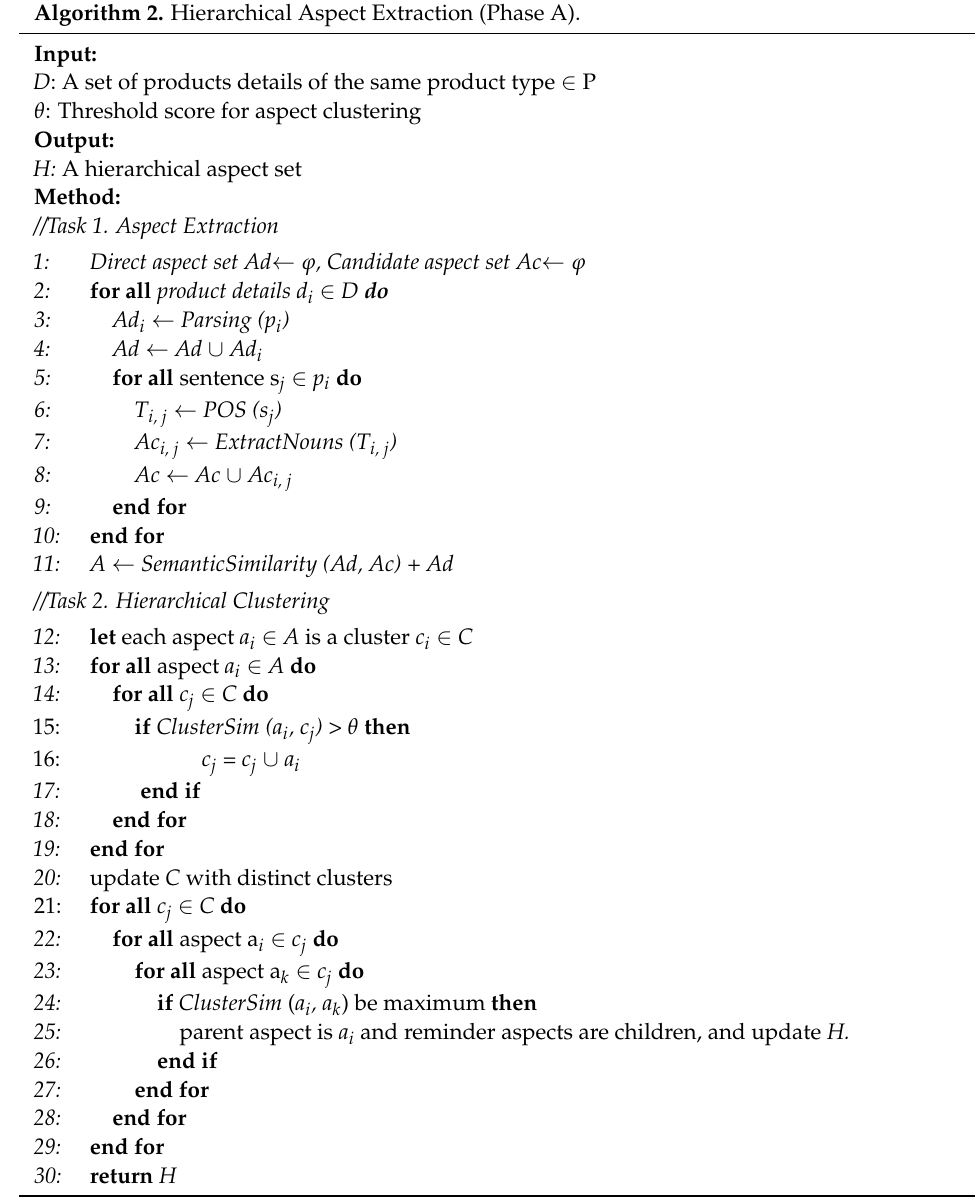
Algorithm 2. Hierarchical Aspect Extraction (Phase